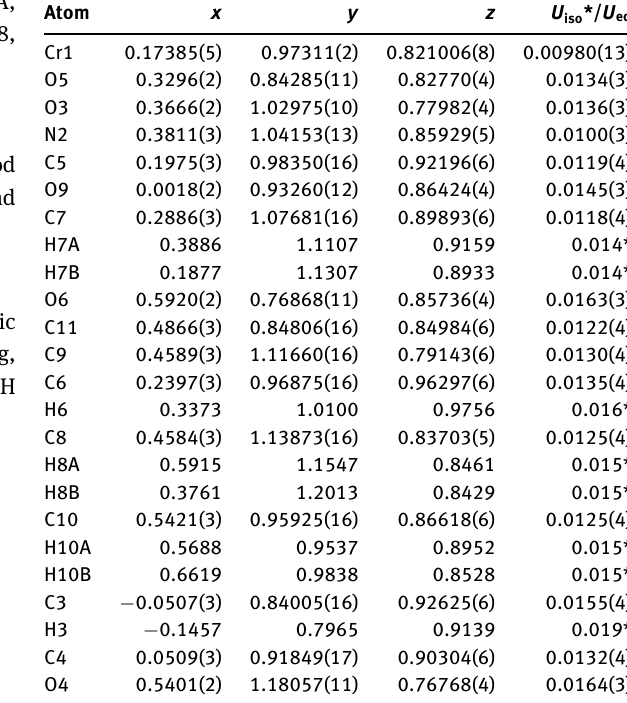
Table 2: Fractional atomic coordinates and isotropic or equivalent isotropic displacement parameters (Å 2